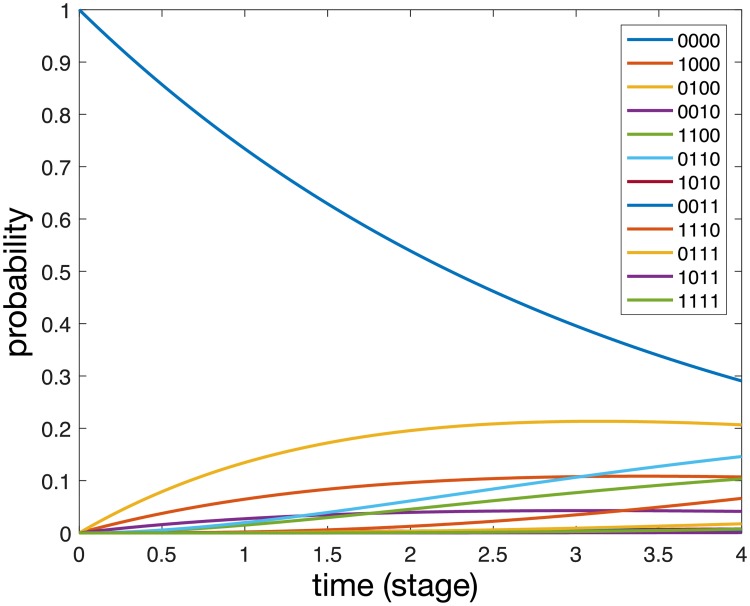
A solution to Eq (3) with parameter values obtained from the maximum likelihood method.Each curve correspond to specific state of the system.